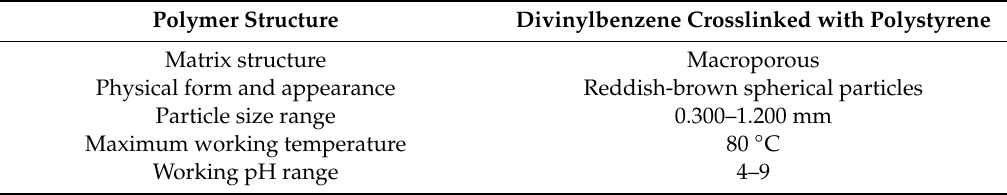
Table 1. Properties of Purolite Arsen X np